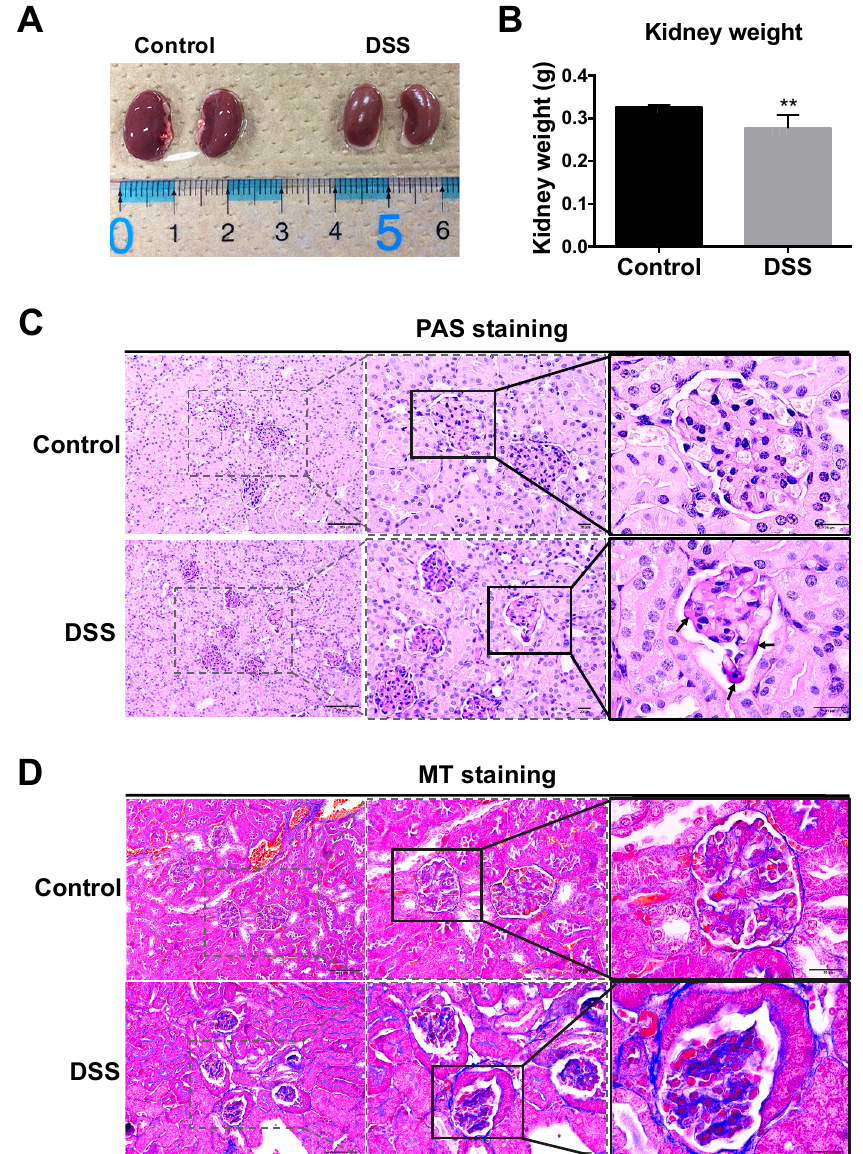
Figure 3. Macro- and microscopic changes to the kidney and glomeruli in mice after DSS administration. Mouse kidney appearance ( A ) and weight ( B ) were determined at harvest. Histological manifestations were determined by staining with periodic acid-Schiff (PAS) to assess the basement membrane of glomeruli ( C ), and Masson’s trichrome (MT) staining to assess collagen deposition ( D ), respectively. Compared to control mice, glomerular accumulation of PAS-positive matrix (arrow) was prominent in DSS-treated mice ( C ). Blue staining indicates the presence of collagen fibers in tissues ( D ). All values are given as mean ± SEM ( n = 6 mice); ** p < 0.01 vs. control. Scale bars: 100 μ m and 20 μ m.